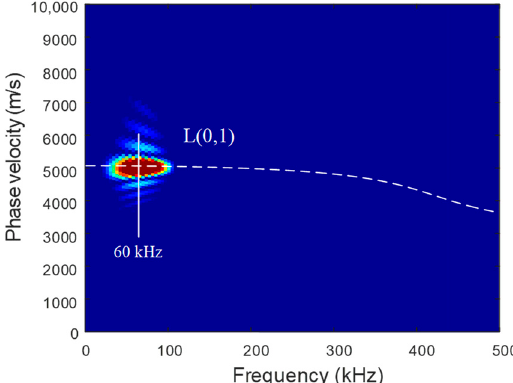
Figure 8. The phase velocity dispersion spectrum from nodal accelerations with a Hann-windowed, five-cycle, 60 kHz sinusoidal tone burst along the z -direction. The theoretical phase velocity dispersion curve of the L(0,1) mode obtained in Figure 1a is represented by a black dotted line.